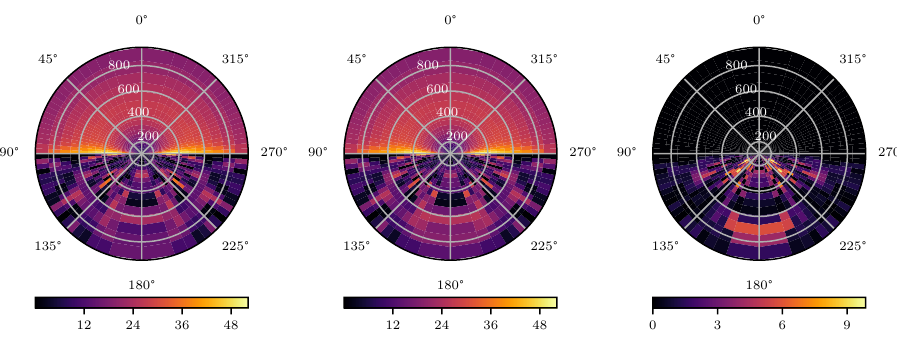
Figure 7 . Polar plot of the DUNE atmospheric (cid:23) (cid:22) appearance rates over 40 zenith bins from cos (cid:18) [ 0 : 975 ; 0 : 975] ( (cid:18) plotted here as the polar angle) and E (cid:23) [100 ; 1000] MeV (plotted in the 2 (cid:0) 2 radial direction). Standard interactions ( (cid:15) O = 0, left), NSI ( (cid:15) O = 0 : 2, (cid:15) O = 0 : 1, (cid:15) O = 0 : 2, center) ee (cid:28)(cid:28) e(cid:28) (cid:11)(cid:12) and their di(cid:11)erence N SI N NSI (right) are plotted. j (cid:0) j method on the oscillation hamiltonian in conjunction with a simpli(cid:12)ed version of the PREM model for the electron number density in the